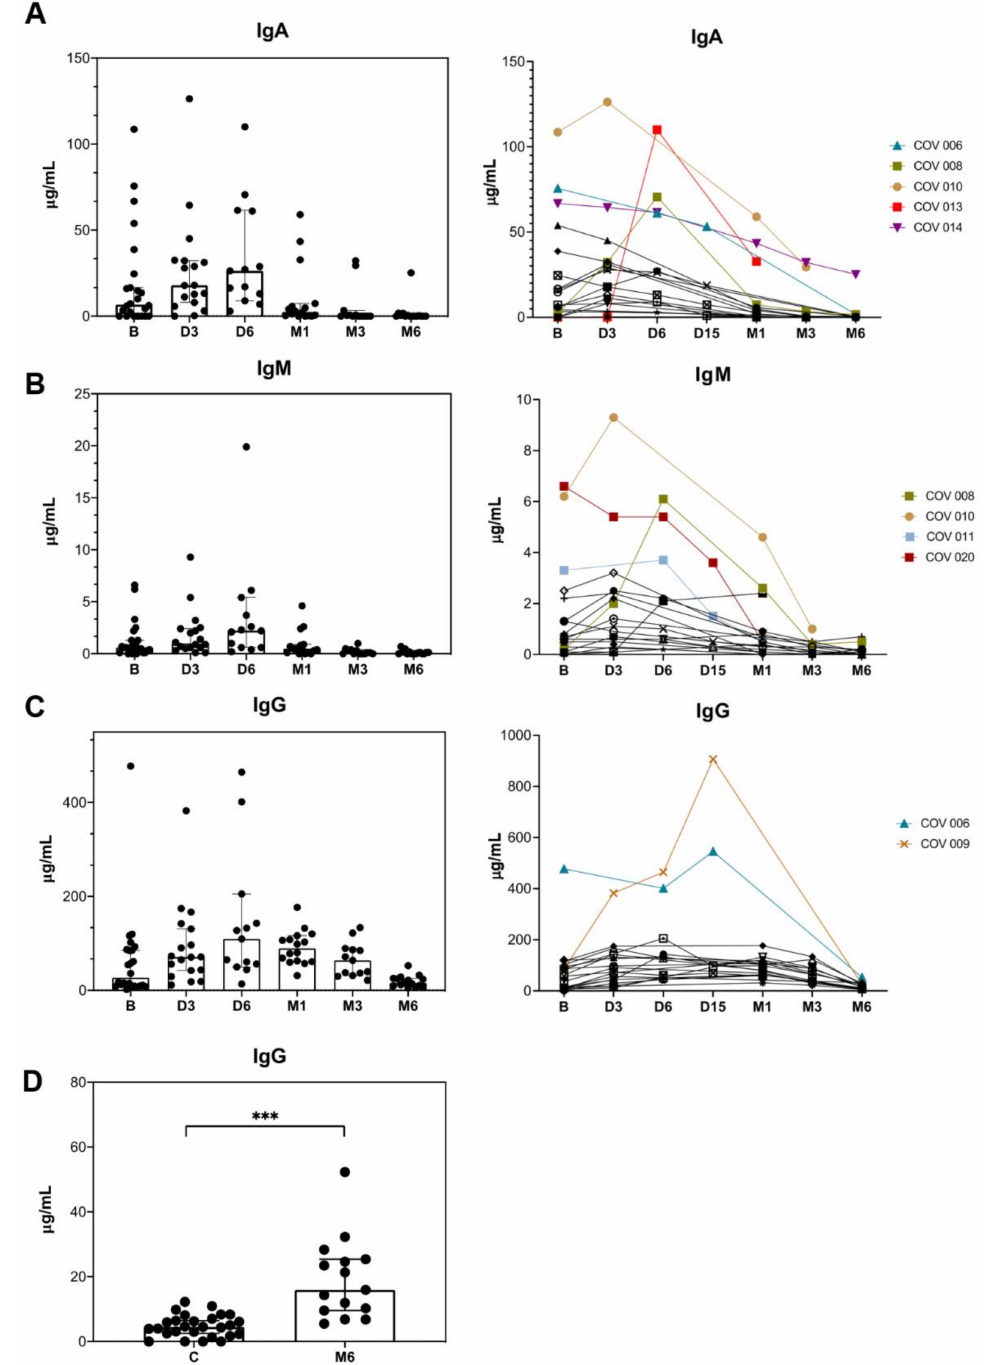
Figure 2. Absolute levels at different time points during the study period and antibodies IgA ( A ), IgM ( B ) and IgG ( C ) kinetics in specific patients. Absolute levels of IgA ( A ), IgM ( B ) and IgG ( C ) among the overall study population ( n = 24) at baseline (B), day 3 (D3), day 6 (D6), month 1 (M1), month 3 (M3) and month 6 (M6) after SARS-CoV-2 infection and changes of serum IgA ( A ), IgM ( B ) and IgG ( C ) antibodies in specific patients ( n = 19) at baseline (B), day 3 (D3), day 6 (D6), month 1 (M1), month 3 (M3) and month 6 (M6) after SARS-CoV-2 infection. Patients COV 006, COV 008, COV 009, COV 010, COV 011, COV 013, COV 014 and COV 020 belong to the severe group. ( D ) Comparison of IgG levels between uninfected controls (c) and patients after 6 months of SARS-CoV-2 infection. Mann–Whitney U test. ***, p -value <